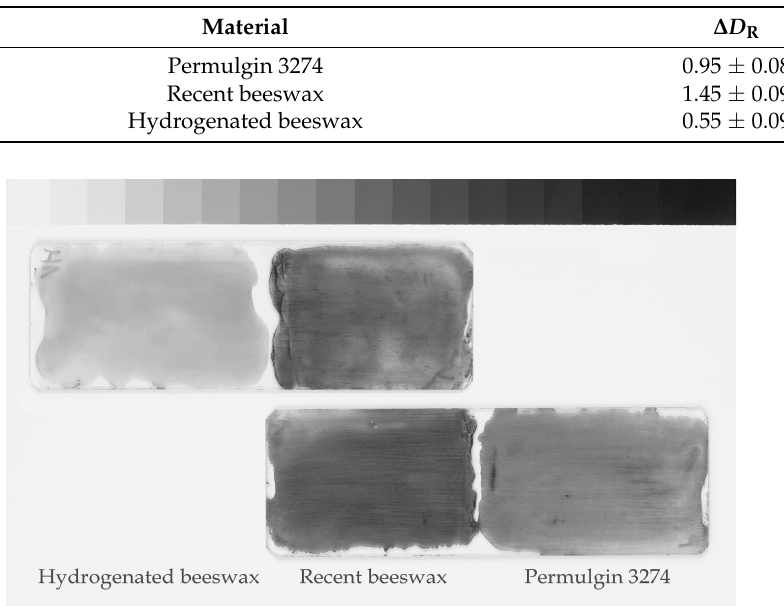
Table 3. Difference of the Status A blue diffuse reflection density ( D R ) of the wax films measured before and after the incrustation of the pigment into the surface. The data are expressed as mean ± standard deviation.